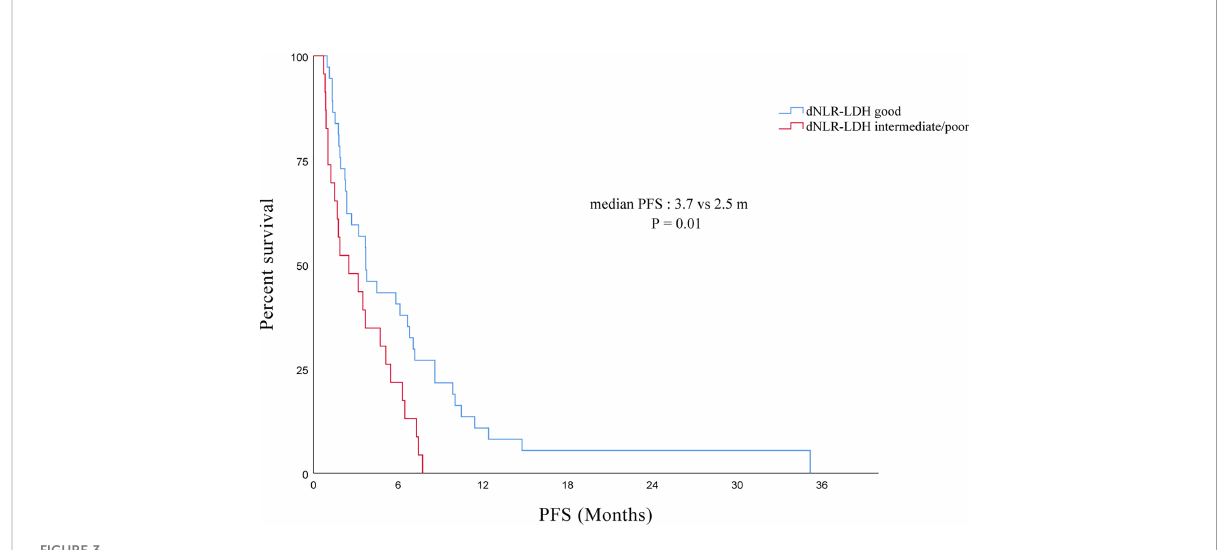
FIGURE 3 Association between pretreatment dNLR-LDH indicator with PFS.